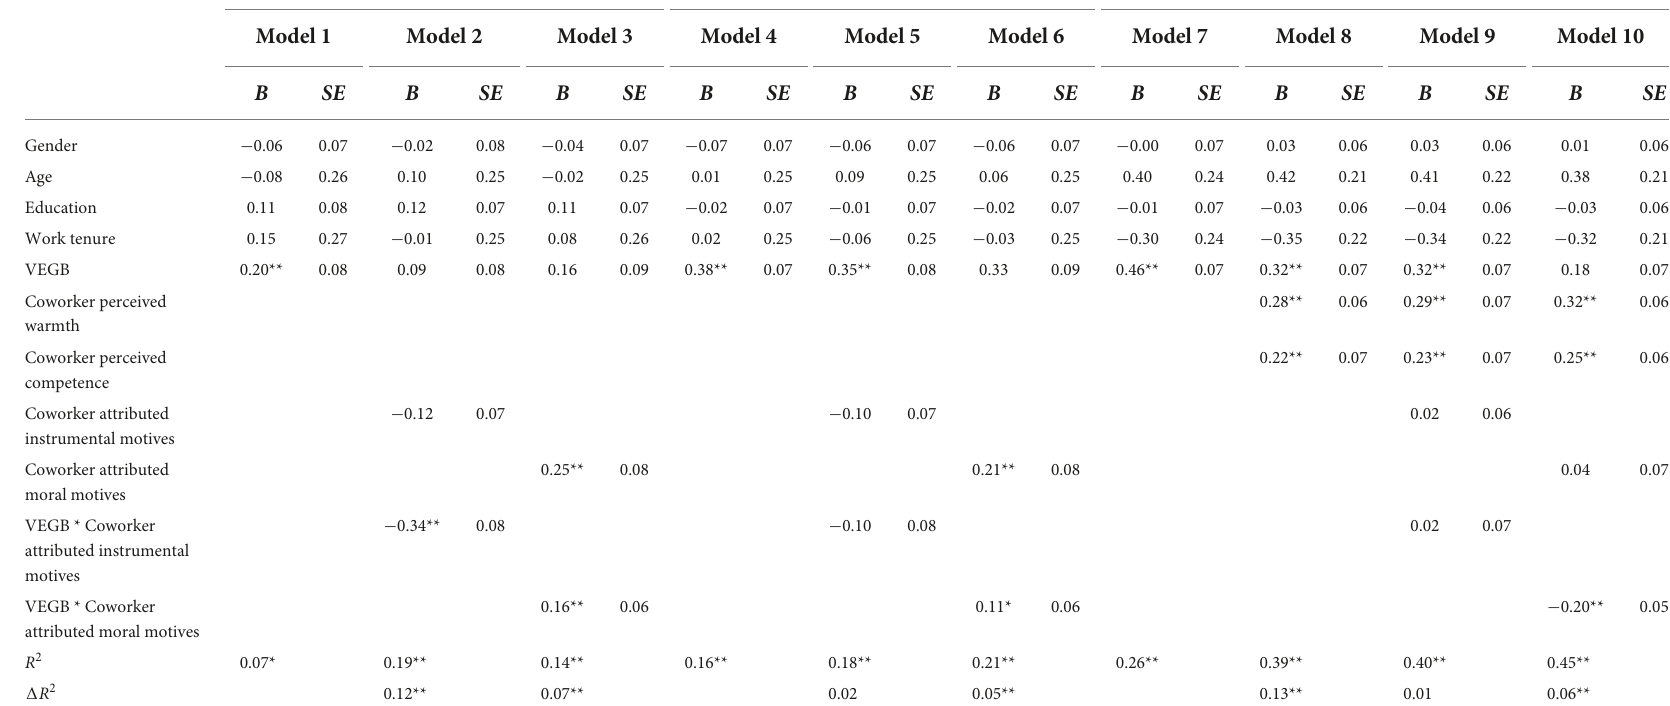
TABLE 3 Summary of multiple regression analysis